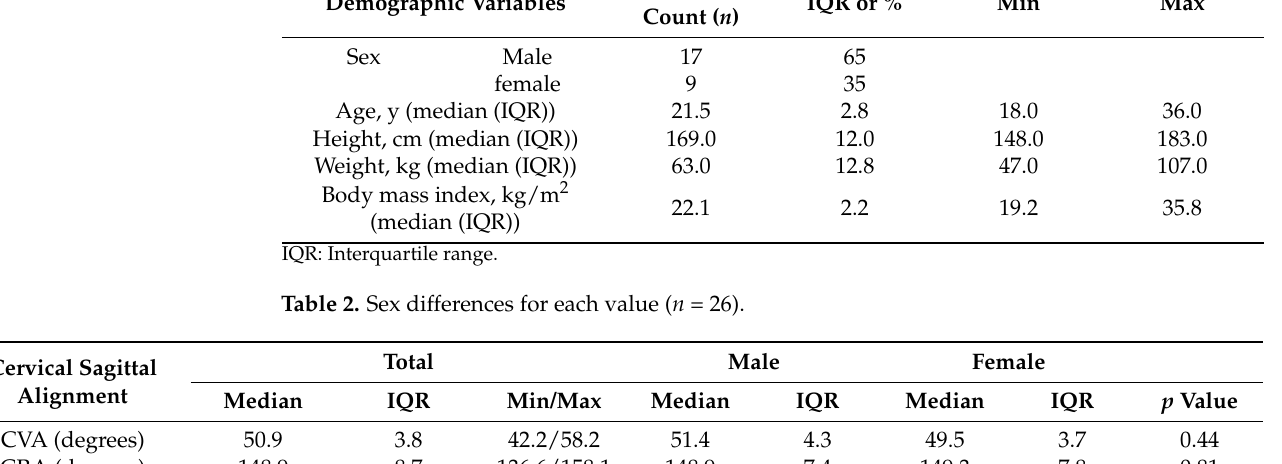
Table 1. Participant characteristics ( n = 26).